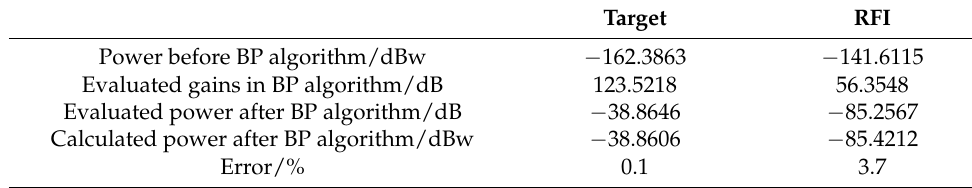
Table 3. GEO-to-LEO RFI focusing results.